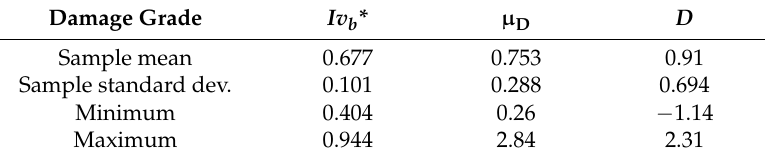
Table 4. Measures of central tendency of the vulnerability index Iv b *, the mean damage grade µ D and the new variable D of the reinforced concrete studied buildings according to the proposed model of the LM1